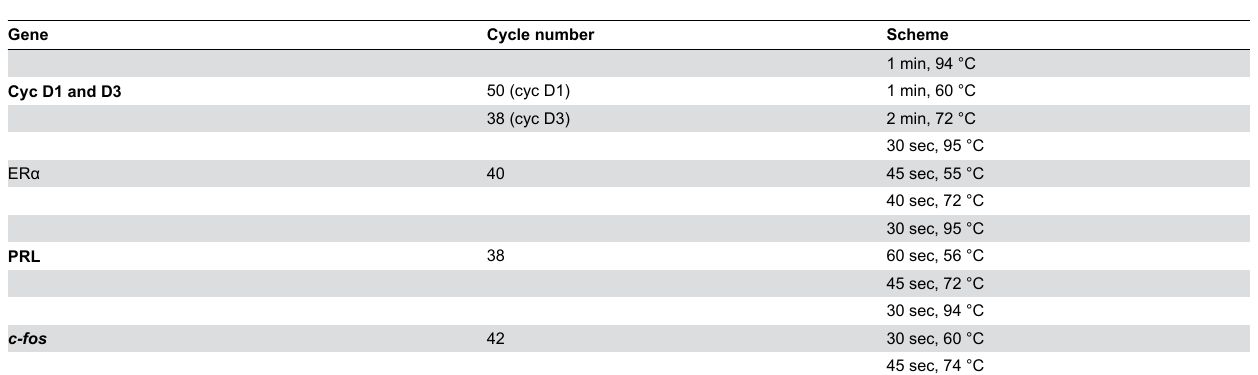
Table 2. PCR amplification